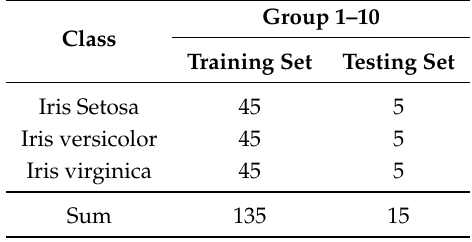
Table 12. Training and testing sets for 10-fold stratified cross-validation. Class